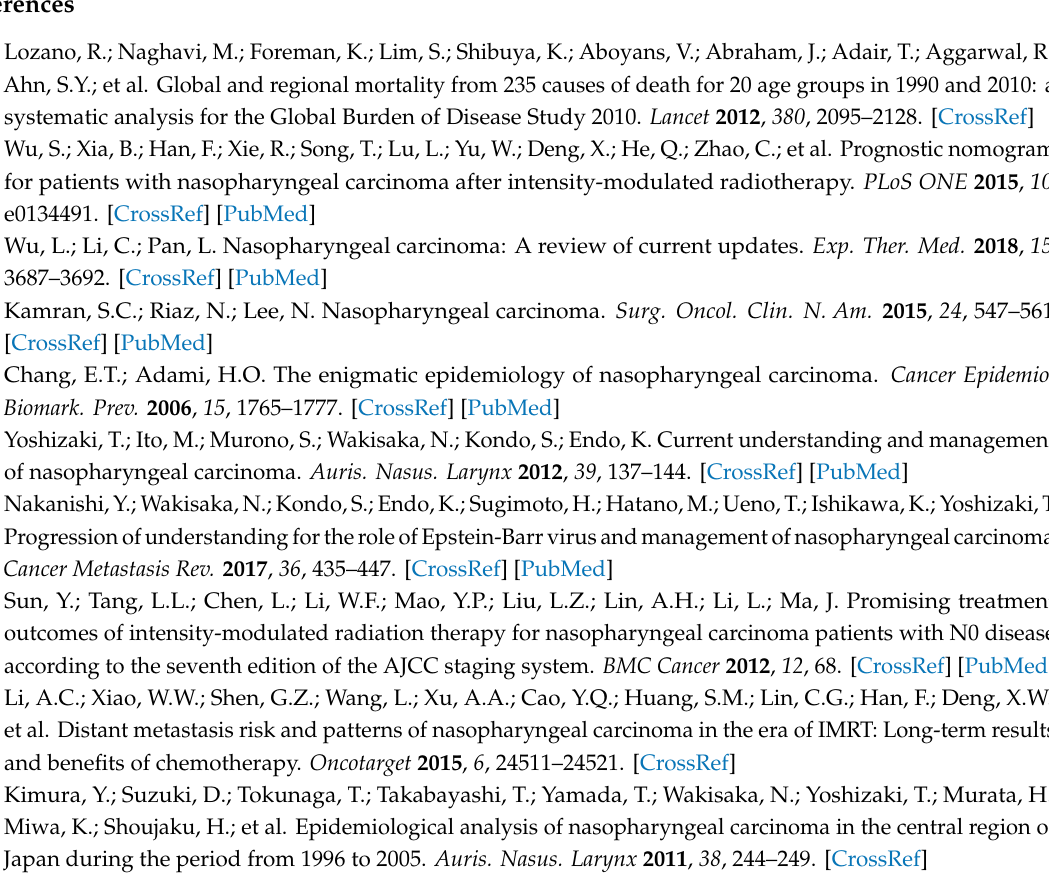
Figure S1: Kaplan–Meier curve for overall survival according to smoking history in smokers and nonsmokers, Figure S2: Pretherapeutic clinical staging according to smoking history, Figure S3: Histologically classification according to the 2005 WHO criteria based on smoking